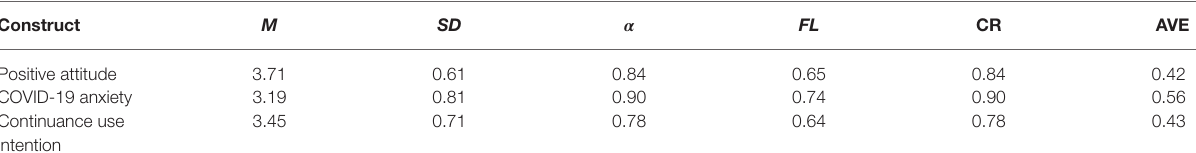
TABLE 2 | Reliability and validity analysis.